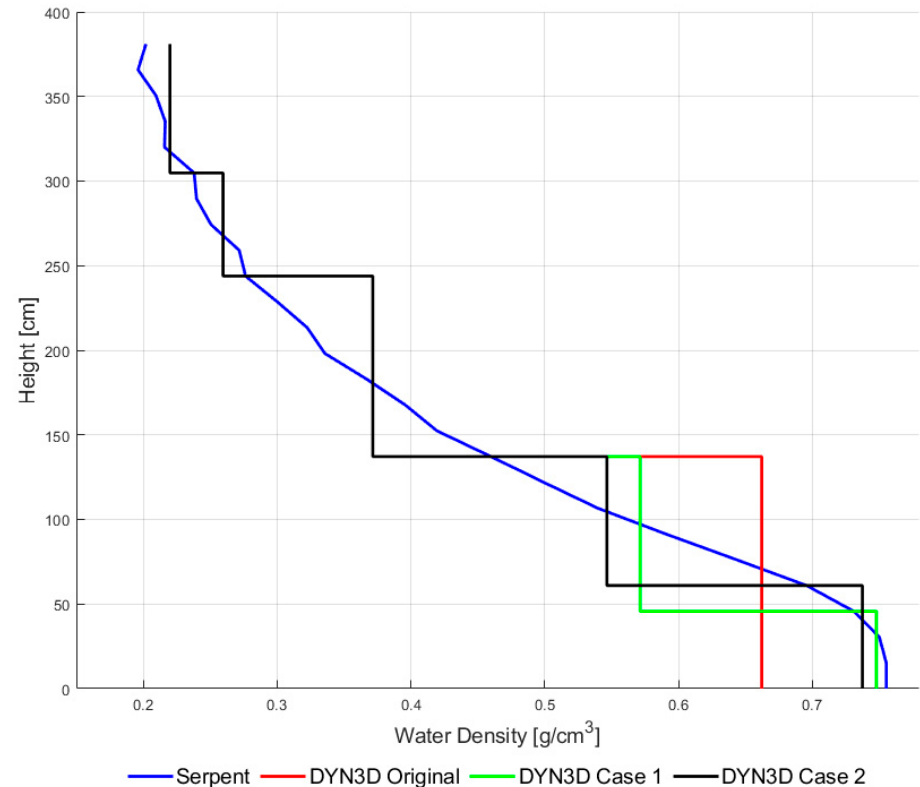
Figure 12. The input water densities across each for both DYN3D and Serpent, with the inclusion of the additional two.